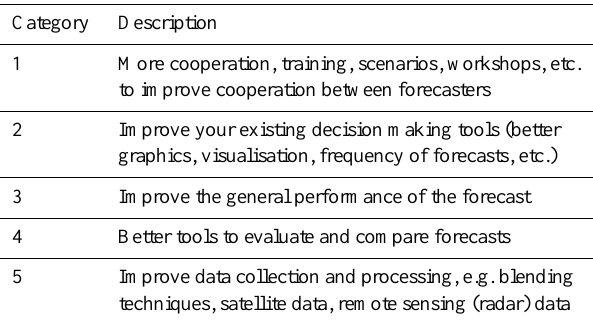
Table 5. Categories of the research priorities for the EFAS forecast